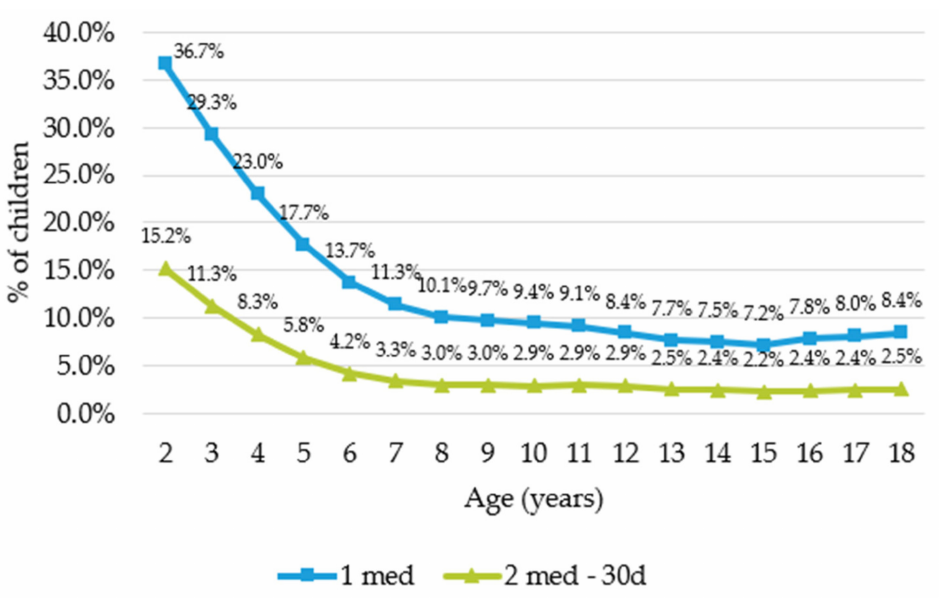
Figure 1. Use of anti-asthmatic drugs in 2018 by age and according to the approach. The use of drug combination ICS-LABA increased with age. In contrast, the use of SABA and SAMA seemed to decrease with age (Figure 2).